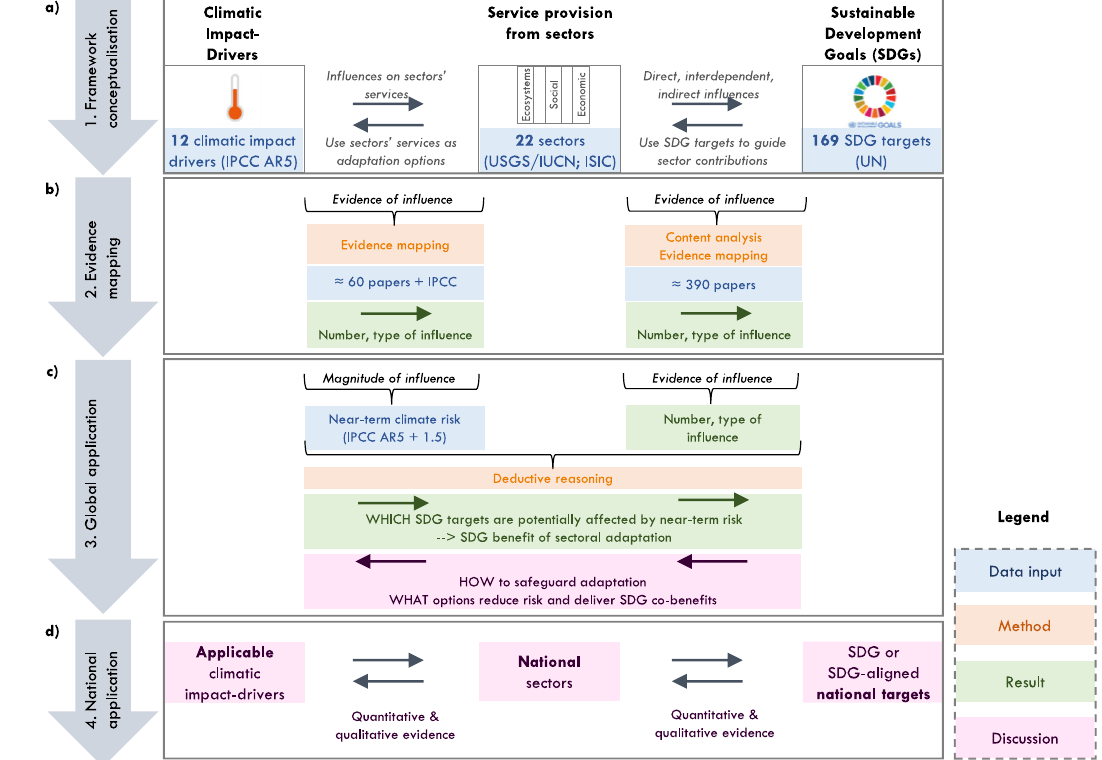
Fig. 2 Conceptualisation and application of our proposed framework for targeting adaptation, which focuses on how sectors mediate between climatic impact-drivers and SDG target achievement. a Framework conceptualisation. b Evidence mapping based on potential in fl uences. c Global application based on IPCC 5th Assessment Report initial global in fl uences. d Considerations for national application of our framework. Icon images courtesy of United Nations.